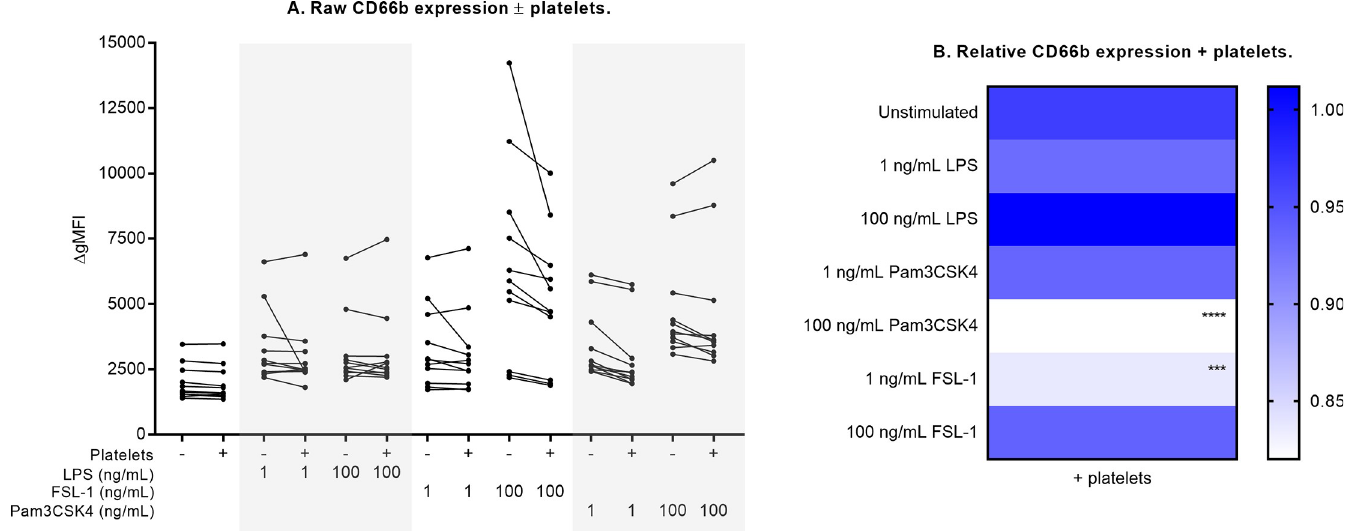
Fig 3. Neutrophil CD66b expression ± platelet co-culture. Raw CD66b expression results are shown in (A). CD66b was measured as Δ gMFI without platelets (- platelets) and with platelets (+ platelets) in unstimulated or TLR-stimulated cultures. For each culture condition, paired measurements (- platelets vs. + platelets) are linked with a solid black line for n = 10 healthy subjects. Relative change in the presence of platelets is shown in (B). Δ gMFI in neutrophil only cultures (- platelets) was normalized to 1 (ble) and each co-culture measurement (+ platelets) was compared to this normalized response. Differences between expression with and without platelets were examined by repeated measures two-way ANOVA with post-hoc Sidak multiple comparisons tests. ��� p < 0.001, ���� p < 0.0001.